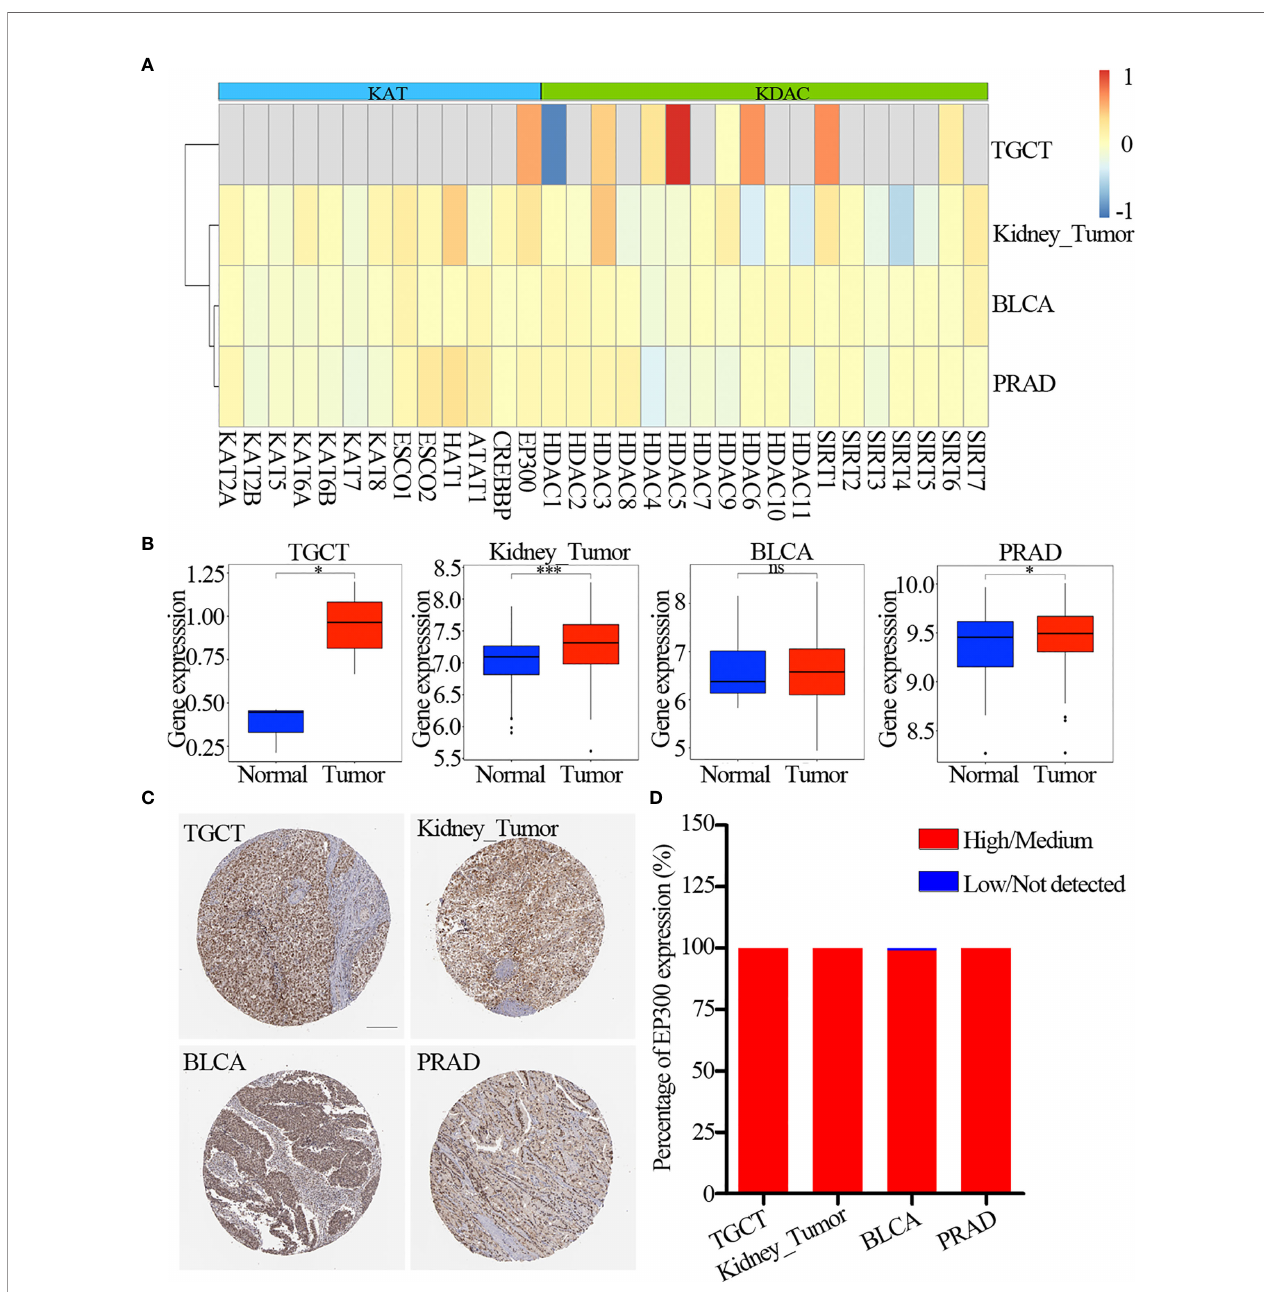
FIGURE 3 | Expression of lysine acetylation regulators in GEO and EBI database. (A) Fold change of dysregulation genes. Red color represents upregulation genes and blue color represents downregulation genes. (B) The expression of EP300 in four cancer types. The blue color represents normal sample, the red color represents tumor sample. (C) Immunohistochemistry images of EP300 in TGCT, kidney_tumor, BLCA and PRAD. Scar bar = 200um. (D) Protein expression percentage of EP300 analyzed by immunohistochemistry. ns means not signi fi cant. *P < 0.05; ***P <